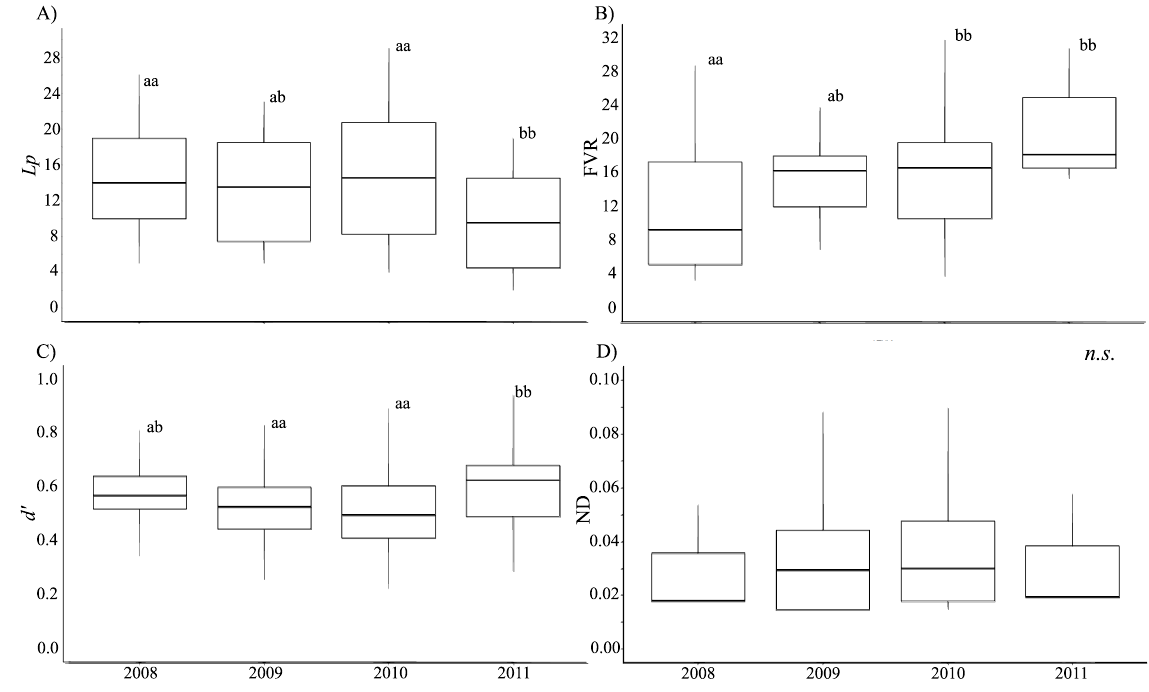
Figure 4. Annual variation of the four response variables studied in the coastal dune community (SB): A) Pollinator species richness per plant ( L p ); B) Flower visitation rate (FVR); C) Complementary specialisation index ( d’ ); and D) normalised pollinator degree (ND). Boxplots show the median, 25th and 75th percentiles and the data range (vertical bar). The bars that share letters are not significantly different from each